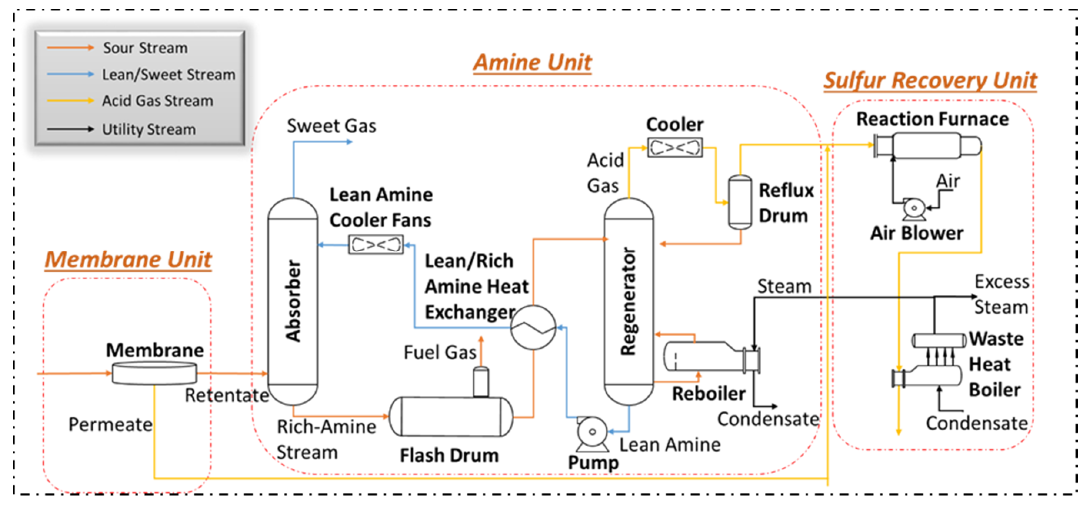
Figure 2. Simplified process flow diagram of the hybrid membrane/amine process.